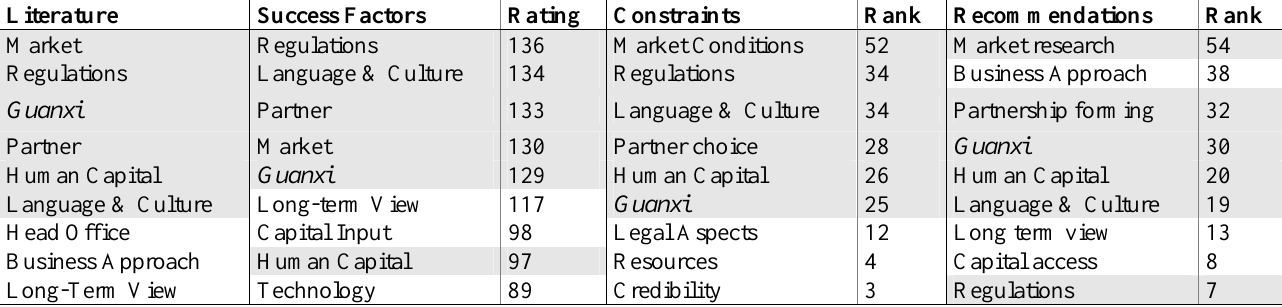
Table 3. Modified summary of findings